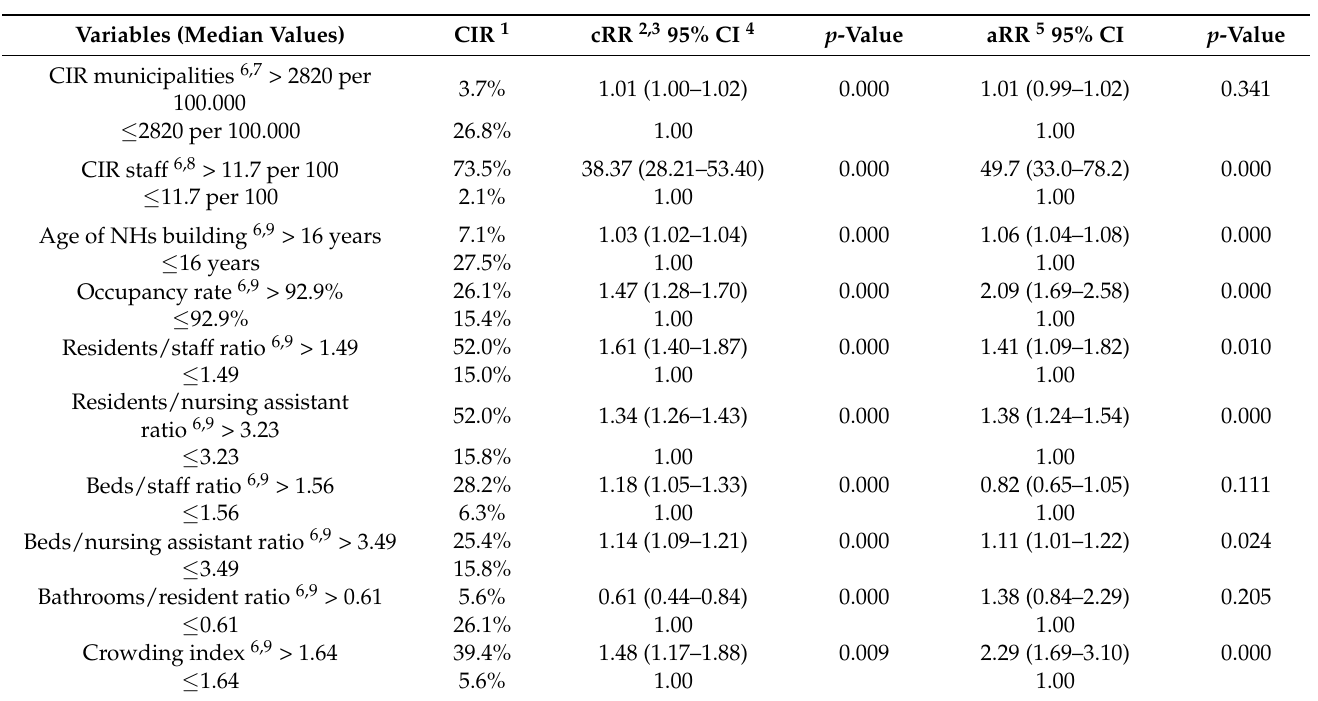
Table 4. Risk factors of the cumulative incidence rate (CIR) of COVID-19 in residents of nursing homes (II). Health Departments 2 and 3 of Castellon. March 2020–January